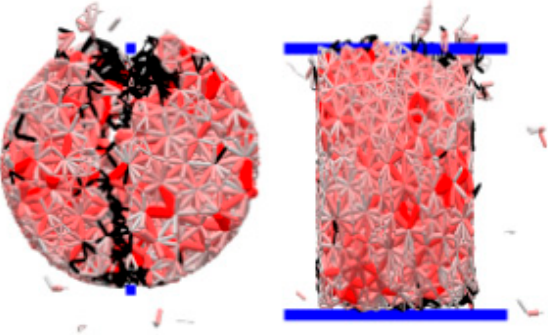
Figure 10. The picture shows the breakage process Brazilian test in a BPM calibration simulation.